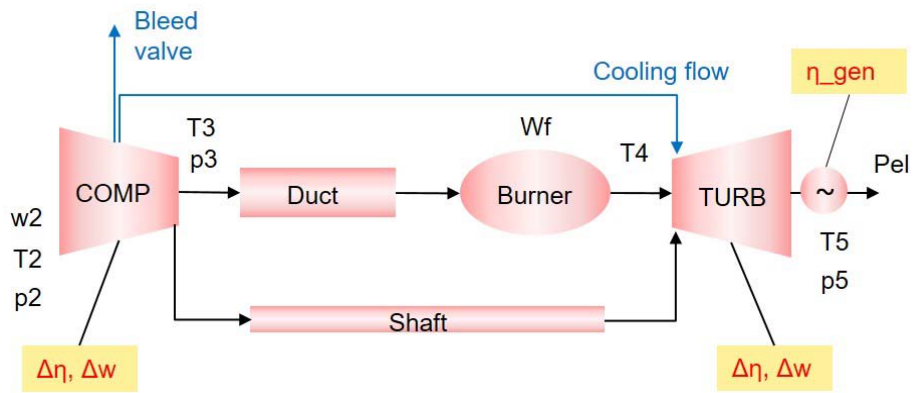
Figure 1. Schematic diagram of the gas turbine model ( η _gen: generator efficiency).